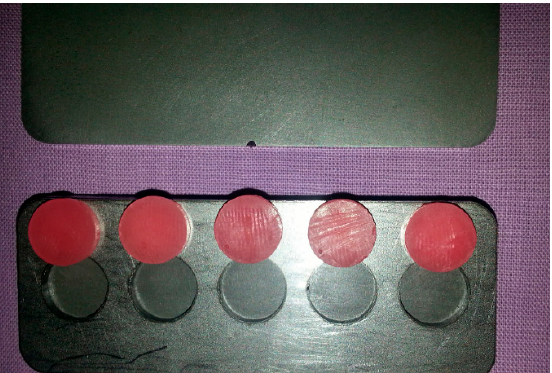
Figure 1. Stainless-steel mold used in the study and disc-shaped wax patterns for CadPM speci- mens.